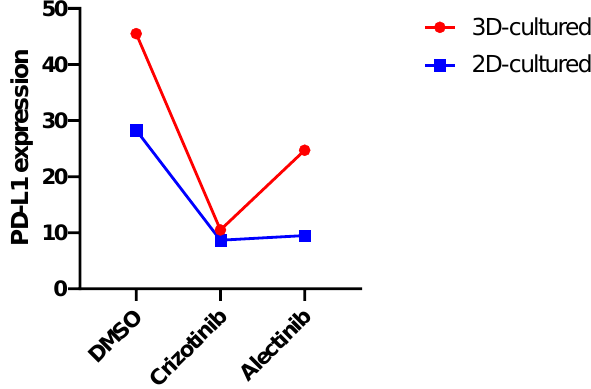
Figure 5. Effect of crizotinib and alectinib on PD-L1 expression in the neuroblastoma cell line, NB39nu, harboring ALK amplification, as determined in the GSE107354 dataset.